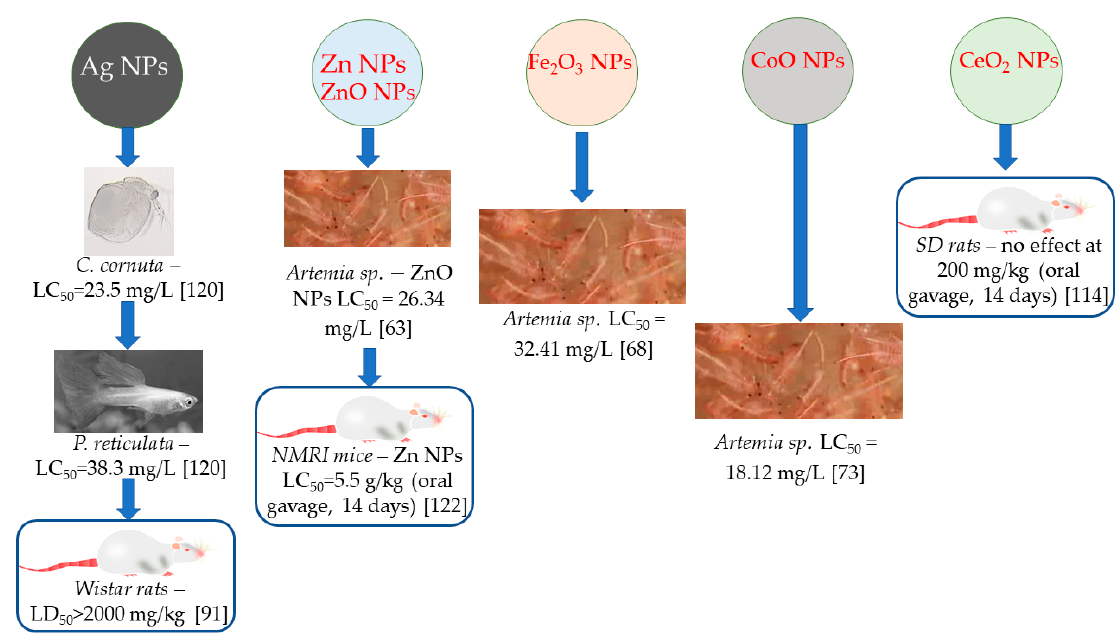
Figure 5. Relevant findings of the in vivo toxicological studies using phytosynthesized nanoparticles; rodent studies are highlighted.